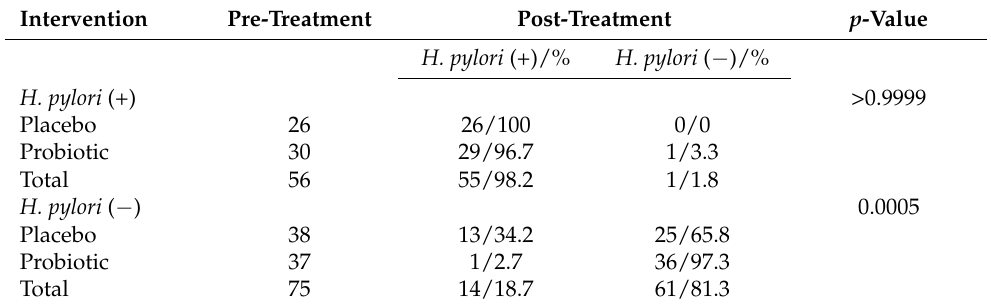
Table 2. H. pylori -infected and non-infected participants before and after the end of the treatment. Intervention Pre-Treatment Post-Treatment